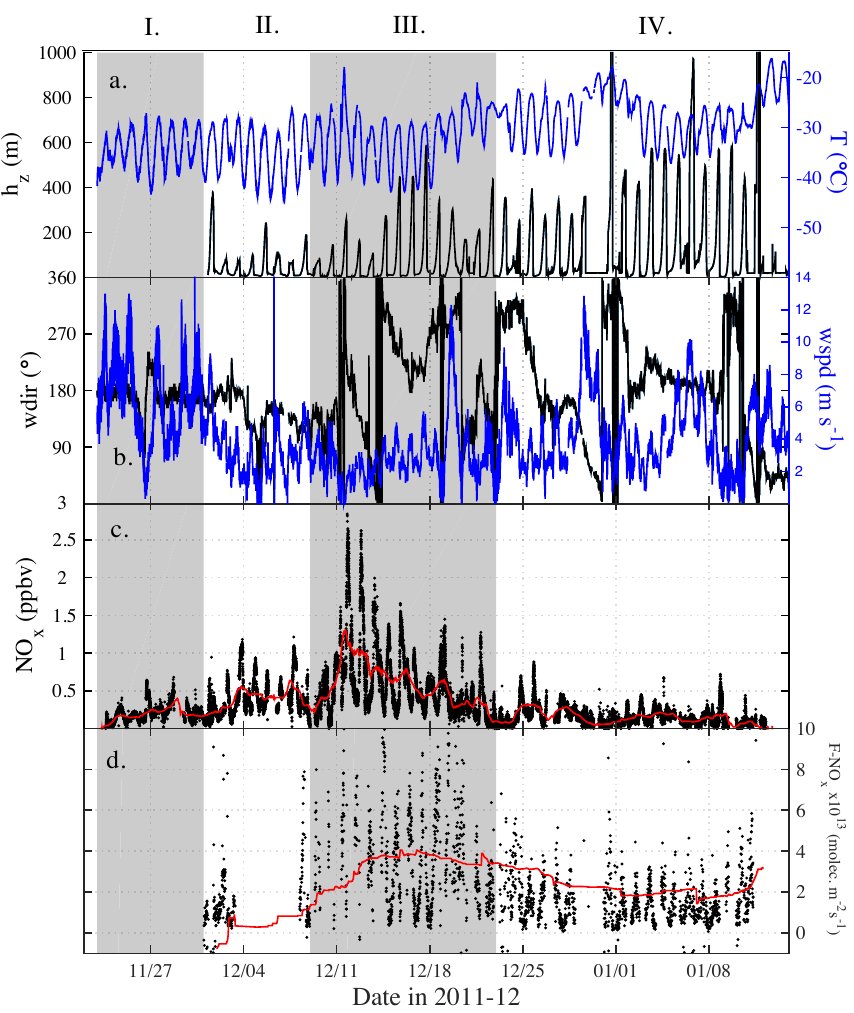
Figure 1. Meterorology and NO x observations at Dome C in summer 2011–2012 (highlighted periods I–IV as referred to in the text and Table 2): (a) air temperature ( T ) at 1.6m and modelled mixing height ( h z ) (Gallée et al., 2015), (b) wind speed (wspd) and direction (wdir) at 3.3m, (c) 1min averages of NO x mixing ratios at 1m (red line is 1-day running mean), and (d) 10min averages of observational estimates of NO x flux ( F NO ) between 0.01 and 1m (red line is 14-day running x